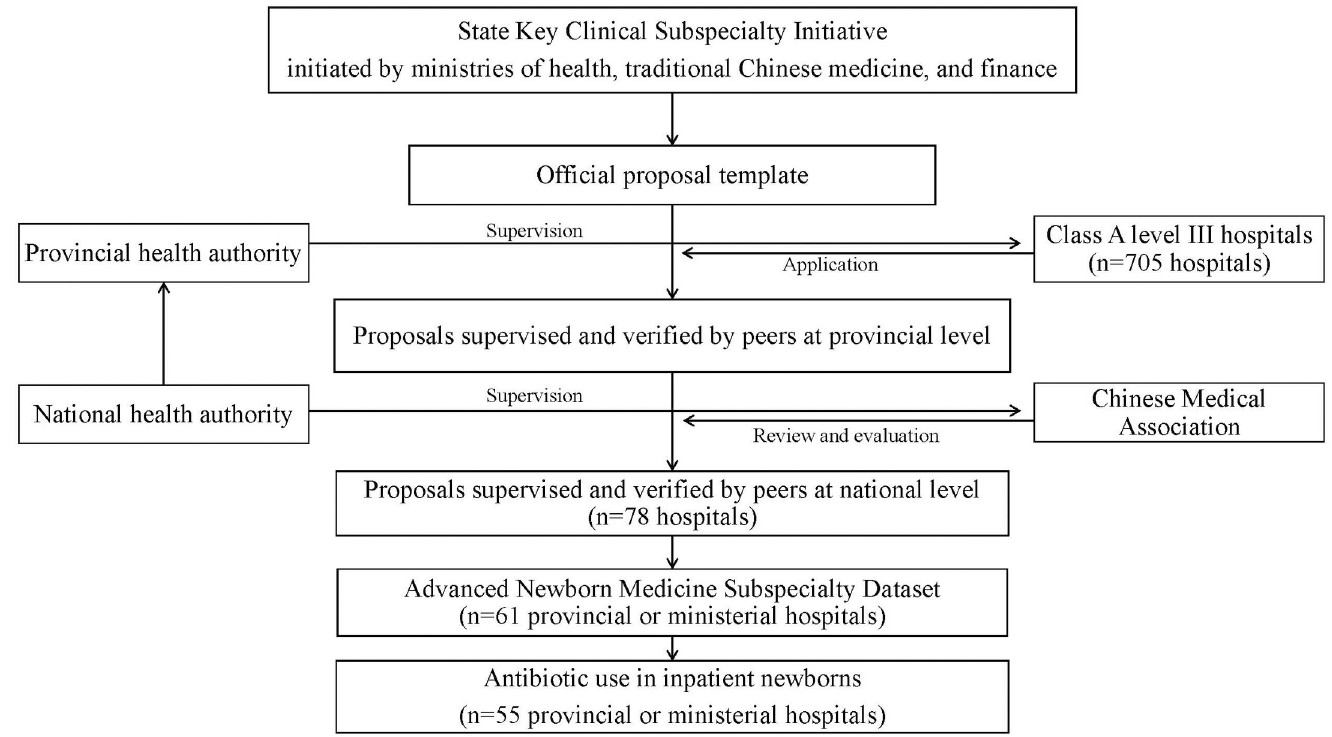
Fig 1. The procedure for data